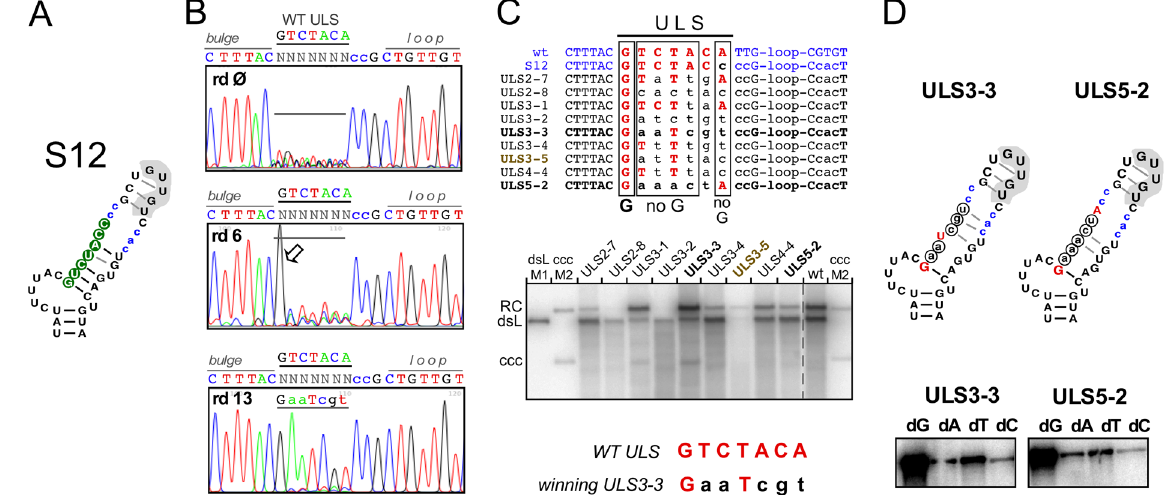
Figure 6. In-cell SELEX reveals the importance of a G residue following the initiation site. SELEX experiments were performed using a starting pool randomized at the seven 5 ′ proximal residues of the left upper stem (ULS) in the context of variant S12. ( A ) Schematic representation of D ε variant S12. Residues in lower case differ from wt-D ε ; randomized nt are shown as white letters on green background. ( B ) In-cell SELEX pool sequencing. Except for a strong selection of G at ULS position 1 (arrowhead) the randomized region remained heterogenous after round 6, and a dominant sequence (ULS3-3) emerged only after round 13. ( C ) Replication capacity of individual ULS sequences. A collection of clones isolated after various SELEX rounds ( top panel ) were analyzed in parallel with wt-DHBV by Southern blotting after transfection into LMH cells. Even clones from early rounds universally contained a G at ULS position 1 but differed substantially from each other at the remaining six ULS positions. Differences in the ratio of RC-DNA vs. dsL-DNA signals as marked as here were not seen in all experiments. ( D ) No impact of multiple non-wild-type nt in the upper left half-stem on dNTP specificity. Wt nt selected during SELEX are shown in red upper case, non-wt nt in encircled lower case. Clones ULS3-3 (the winning sequence after 13 rounds) and ULS5-2 (with wild-type nt only at the first and last randomized ULS position) were analyzed by miniDP priming assays using a single dNTP; both exerted a strong preference